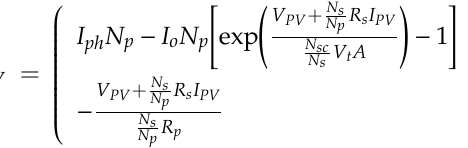
Figure 6. Solar array characteristics for various irradiation levels at a temperature of 25 °C.